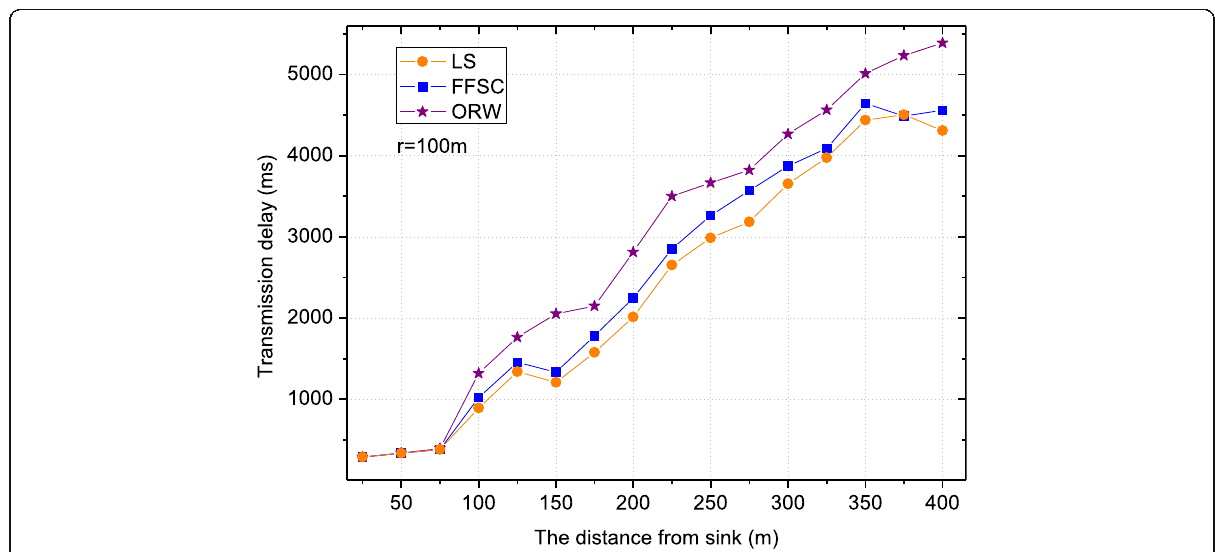
Fig. 13 The total delay under different distance from